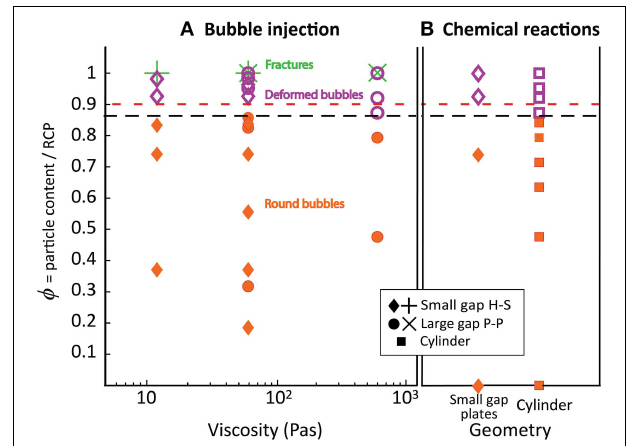
FIGURE 11 | Regime diagram separating the round bubble regime (filled orange shapes), the bubble deformation regime (purple open symbols) and the fracture regime (green crosses). The red dashed line indicates the transition from fingering to fracturing in Sandnes et al. [ 10] and Chevalier et al. [12] at viscosities of 0.01, and 0.005–0.2 Pa s. The black line indicates φ def , determined from regime changes in part I and II. (A) Bubble injection experiments in small-gap parallel plates (diamonds) and large-gap parallel plates (disks), with bubble growth rates of 52 and 93mL/h; (B) Chemical reaction experiments in small-gap parallel plates (diamonds) and cylinder geometries (squares), with bubble growth rates that average 2–3mL/h in the first few hours of the experiments.